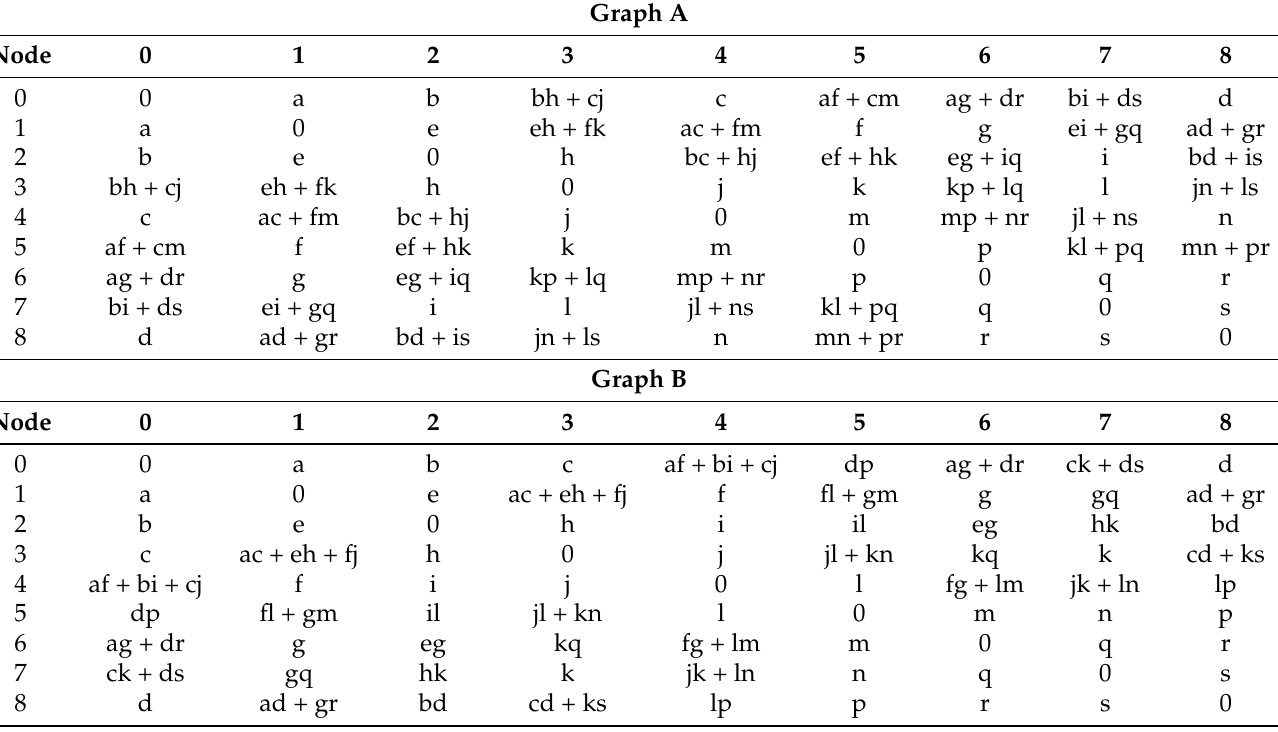
Table 4. Total numbers of uses of specific graph edges in all minimum length